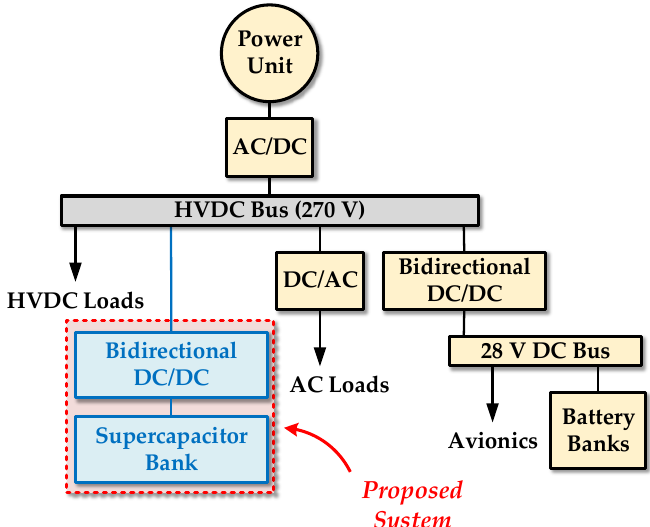
Figure 3. Incorporation of the proposed system into the HVDC bus of a M/A-EA microgrid.